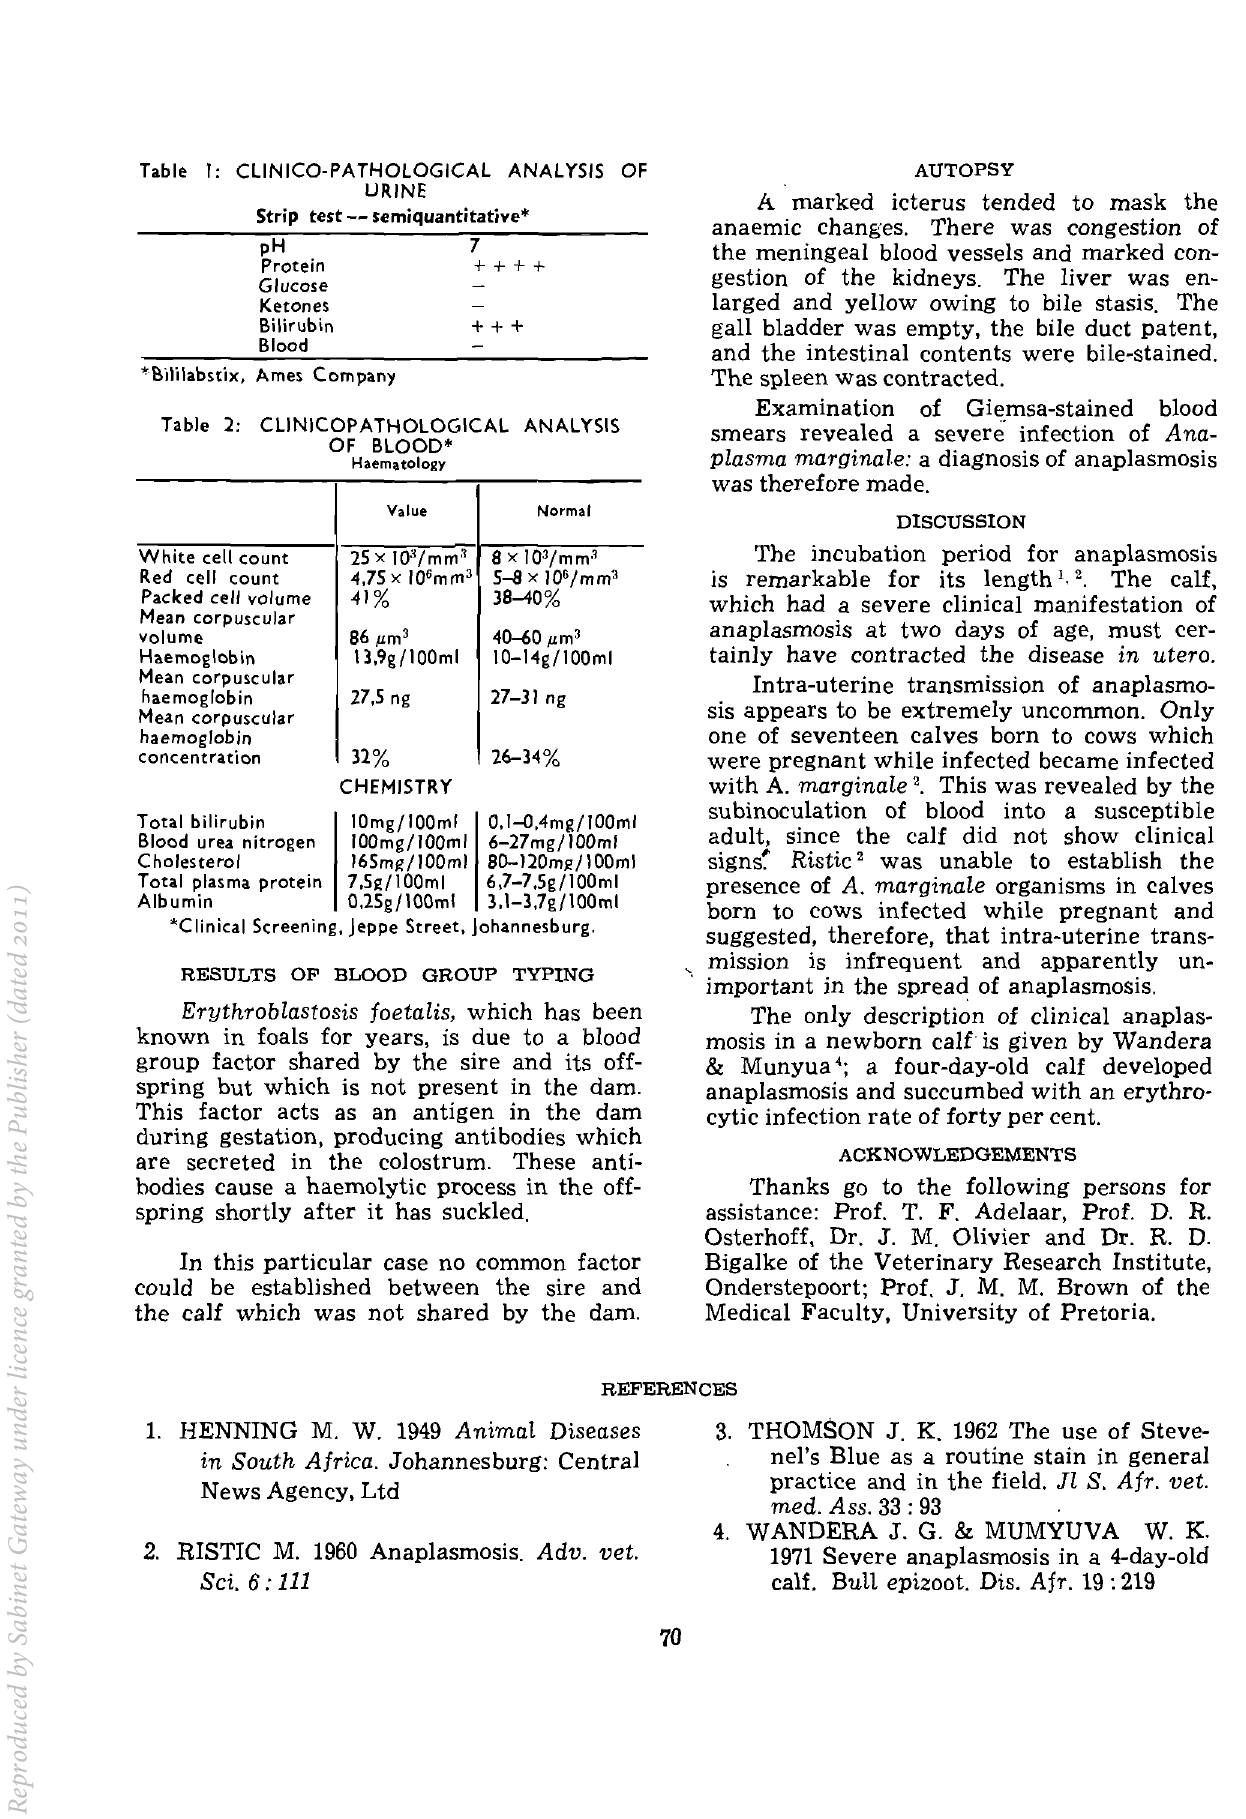
Table I: CLiNICO-PATHOLOGICAL ANALYSIS OF URINE Strip test -- semiquantitative" pH 7 Protein + + + + Glucose Ketones Bilirubin